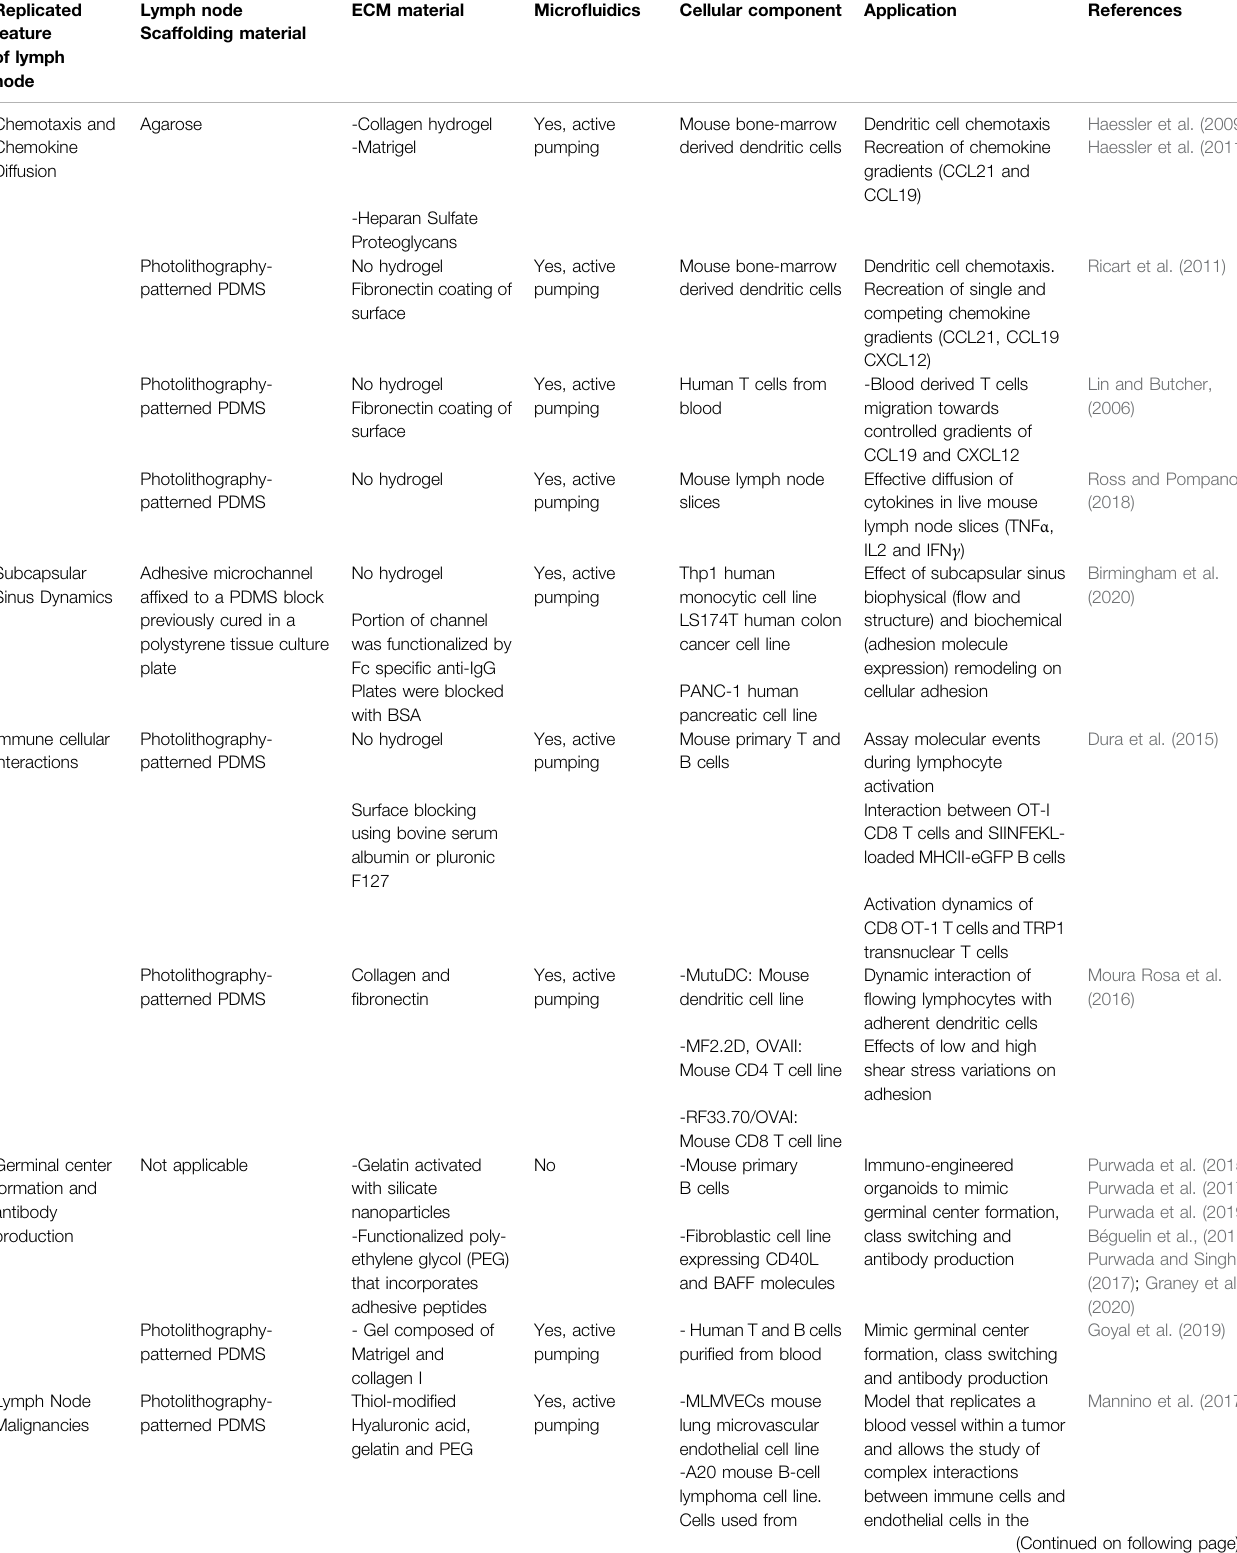
TABLE 1 | Summary of existing attempts to develop in vitro lymph nodes on-chip. Replicated